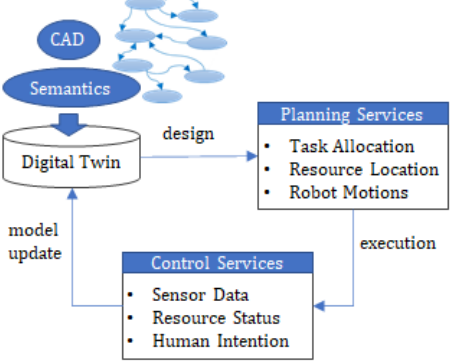
Figure 2. The continuous re-design process.